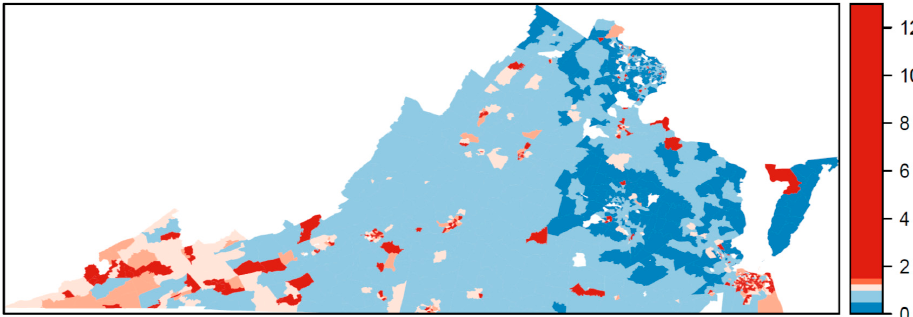
Figure 2. Estimated relative risk for vape shop outlets across Virginia census tracts, 2018.